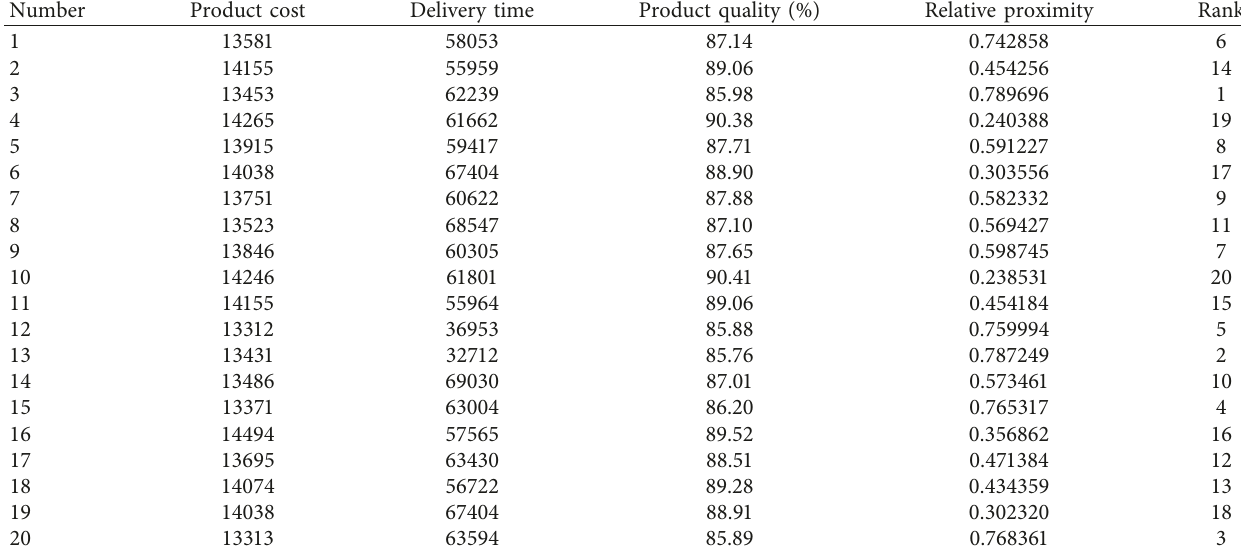
Table 7: Comprehensive ranked list of the production planning scheme.